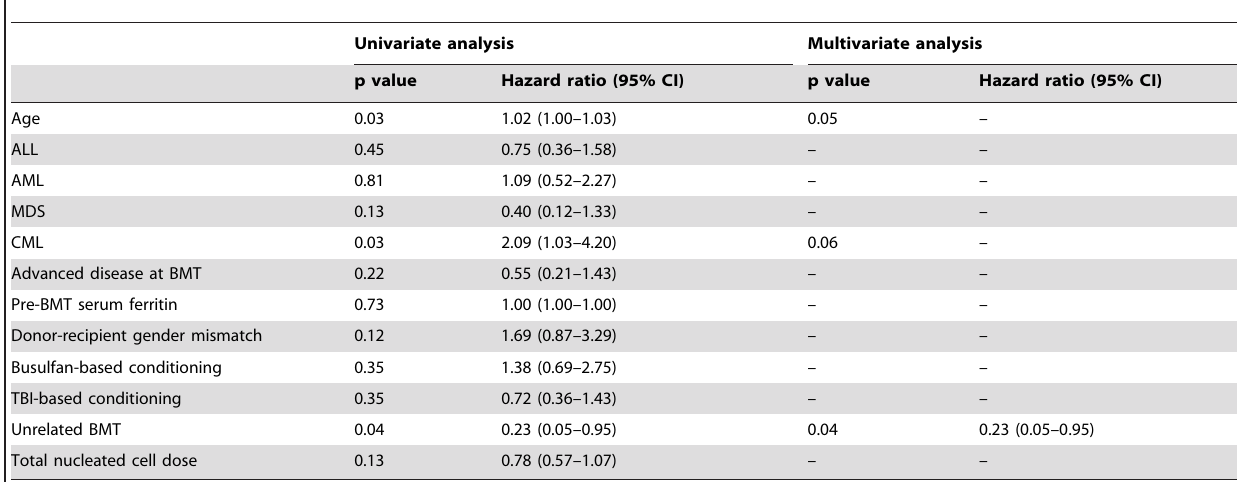
Table 2. Cox regression analysis of variables predictive for moderate-severe chronic